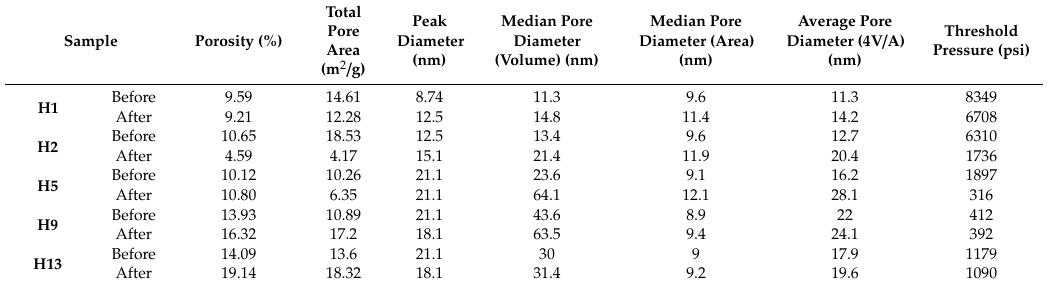
Table 4. Summary of results from the MICP test for samples before and after exposure to scCO 2